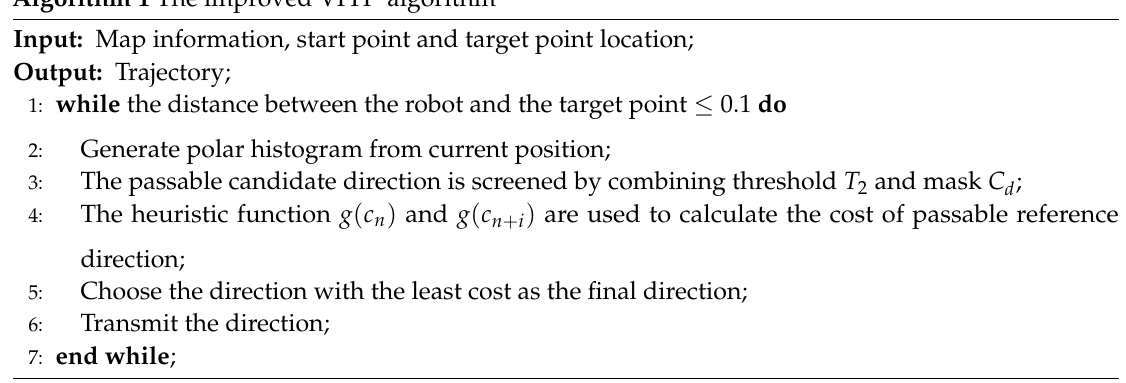
Algorithm 1 The improved VFH*